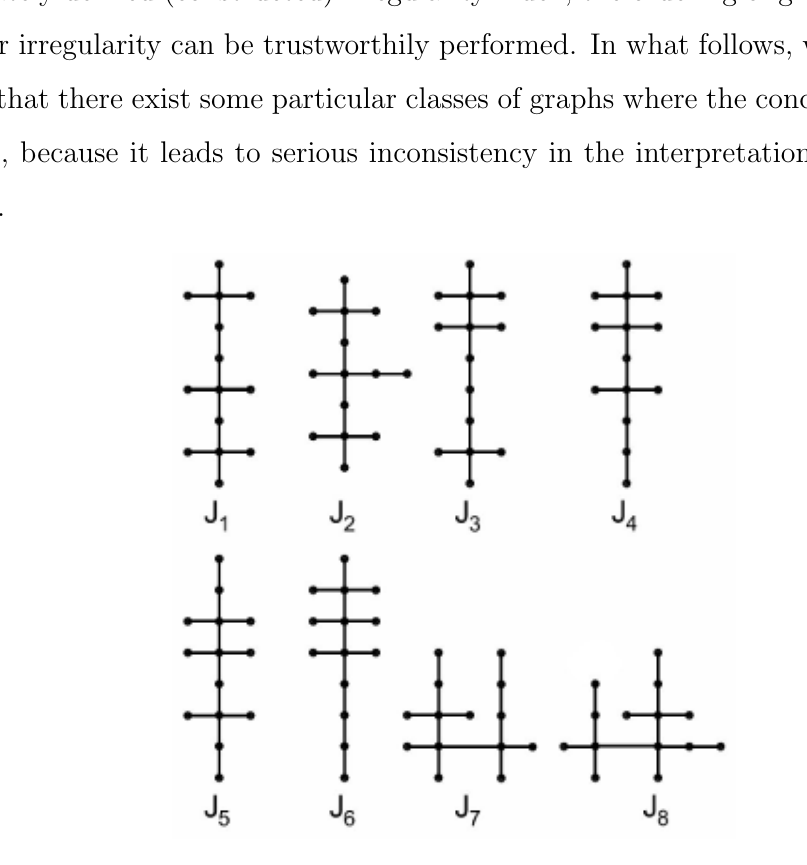
Figure 3: Eight non-isomorphic trees having identical vertex